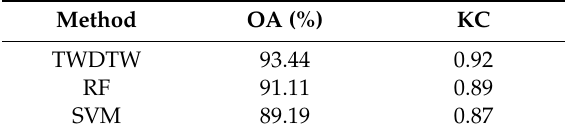
Table 3. Overall accuracy (OA) and kappa coefficient of TWDTW, RF, and SVM applied to another test area.